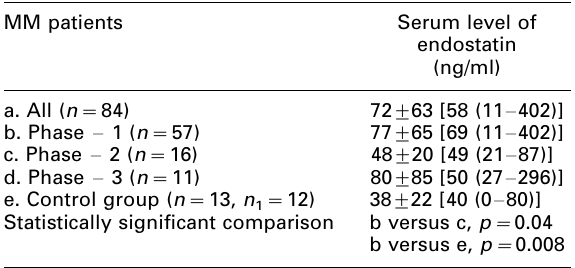
Table 2. Serum levels of endostatin in MM patients at different phases MM patients